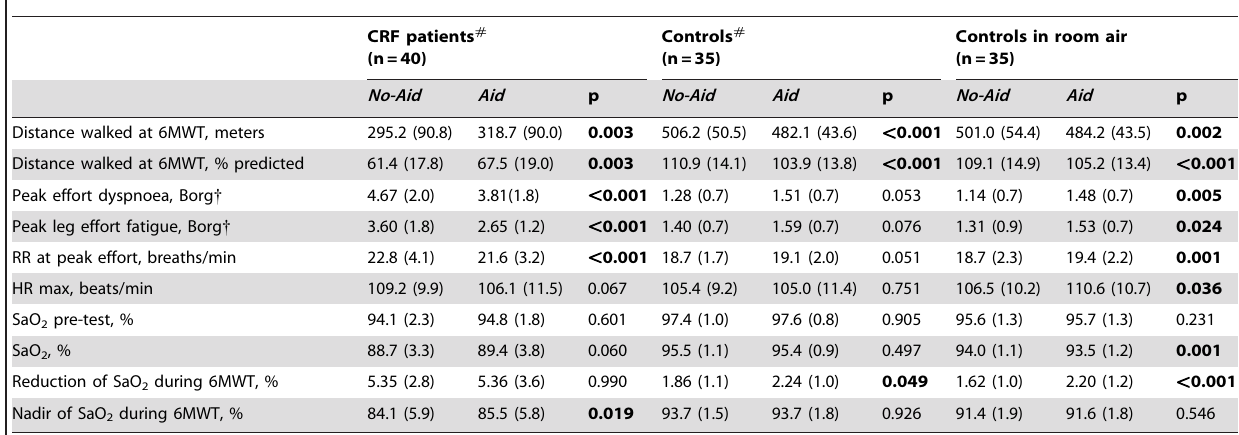
Table 2. Results of the exercise performance in the population in study.